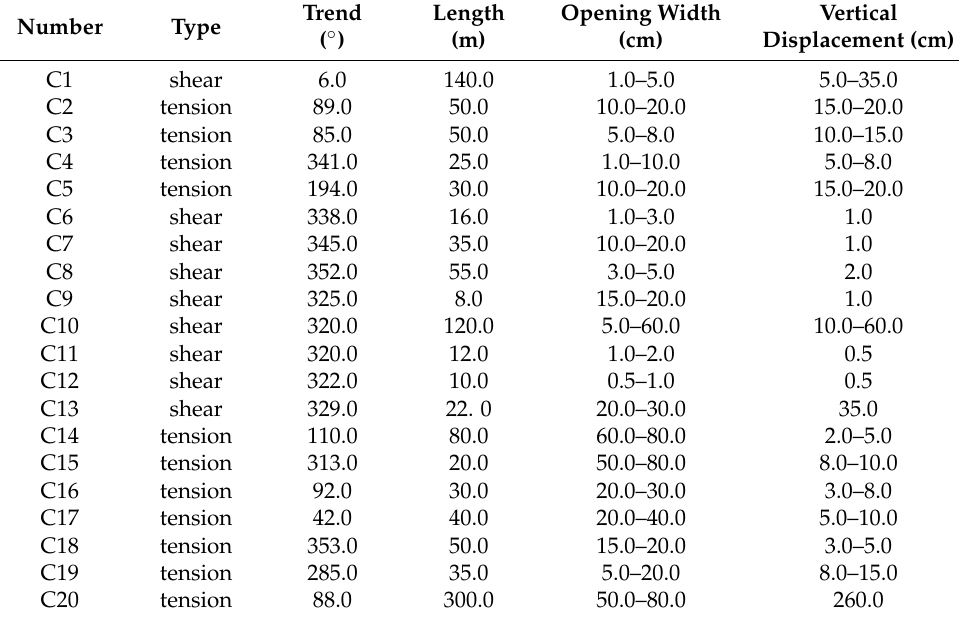
Figure 7. Deformation characteristic of Ganjingzi landslide: ( a ) distribution of cracks and shallow failure, and ( b – h ) macroscopic deformation of Ganjingzi landslide. Table 1. Characteristics of cracks measured during the investigation on 21 July